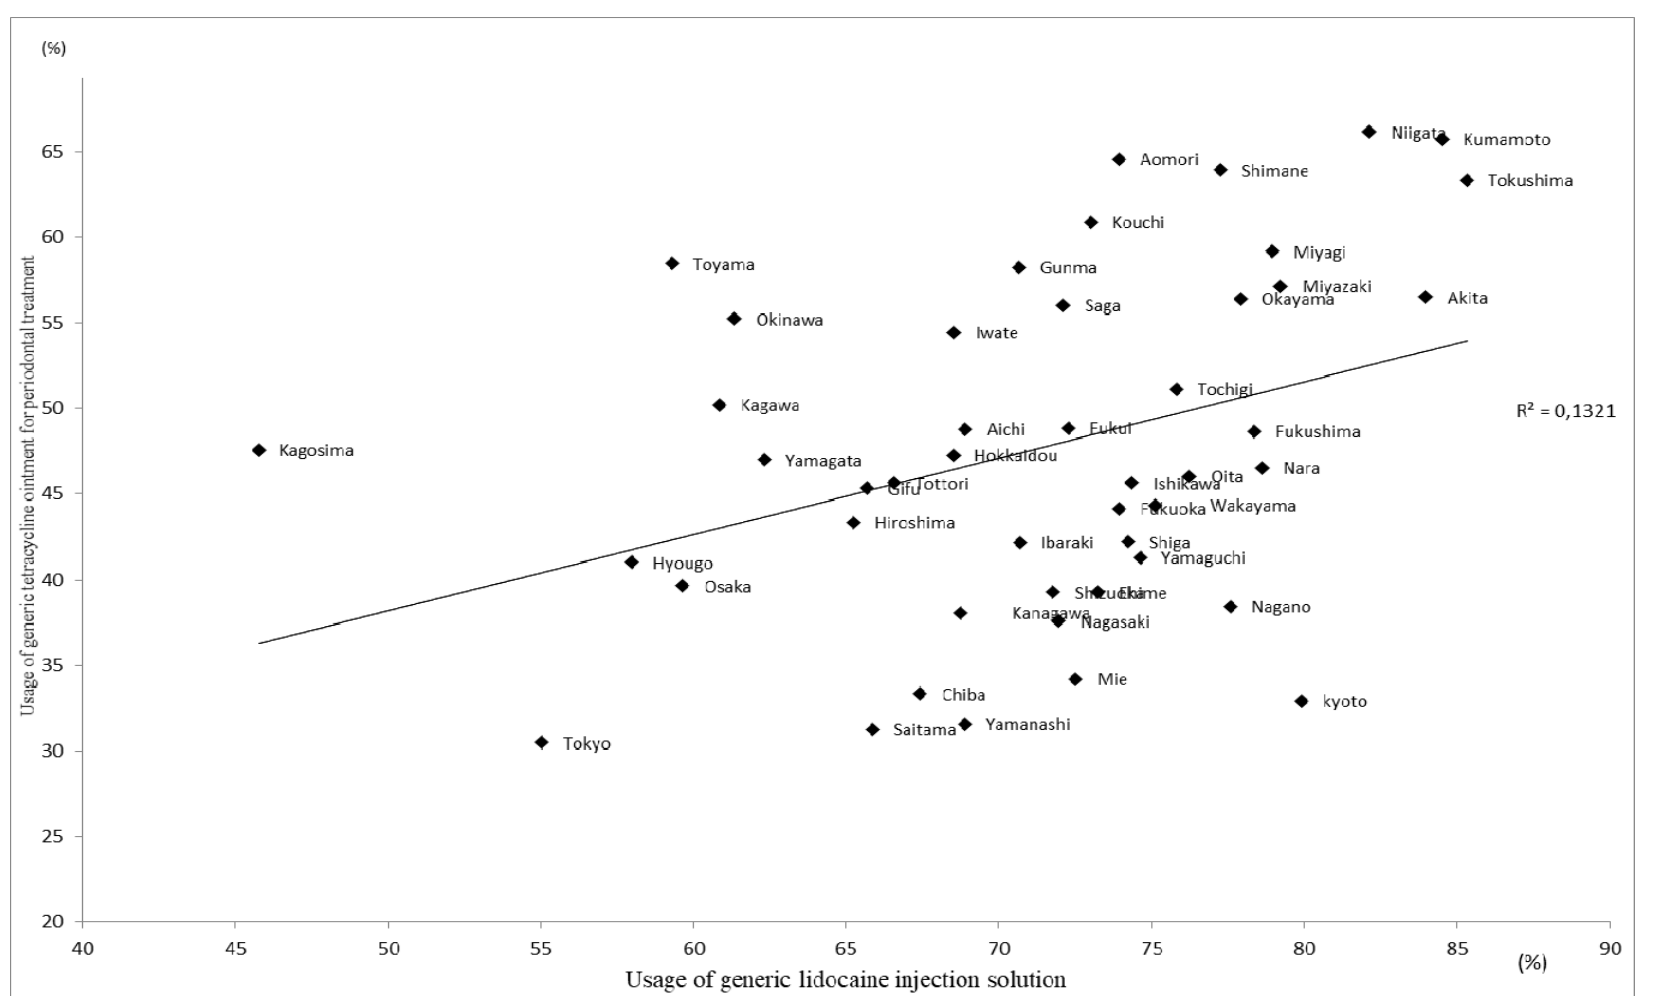
Figure 2. Comparison of usage of generic tetracycline ointment and lidocaine injection solution.